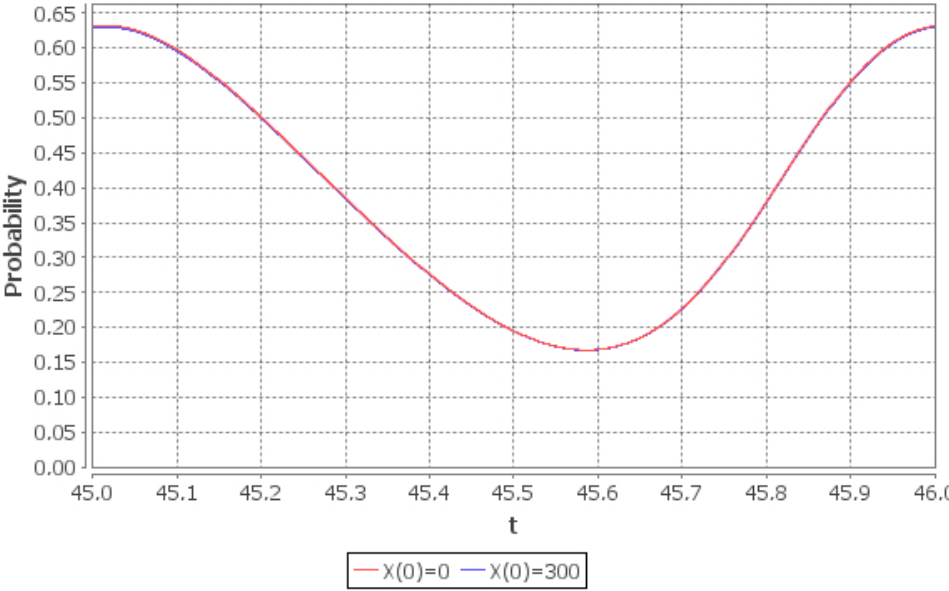
Figure 10. Limiting probability p 0 ( t ) of the empty queue given two different initial conditions: